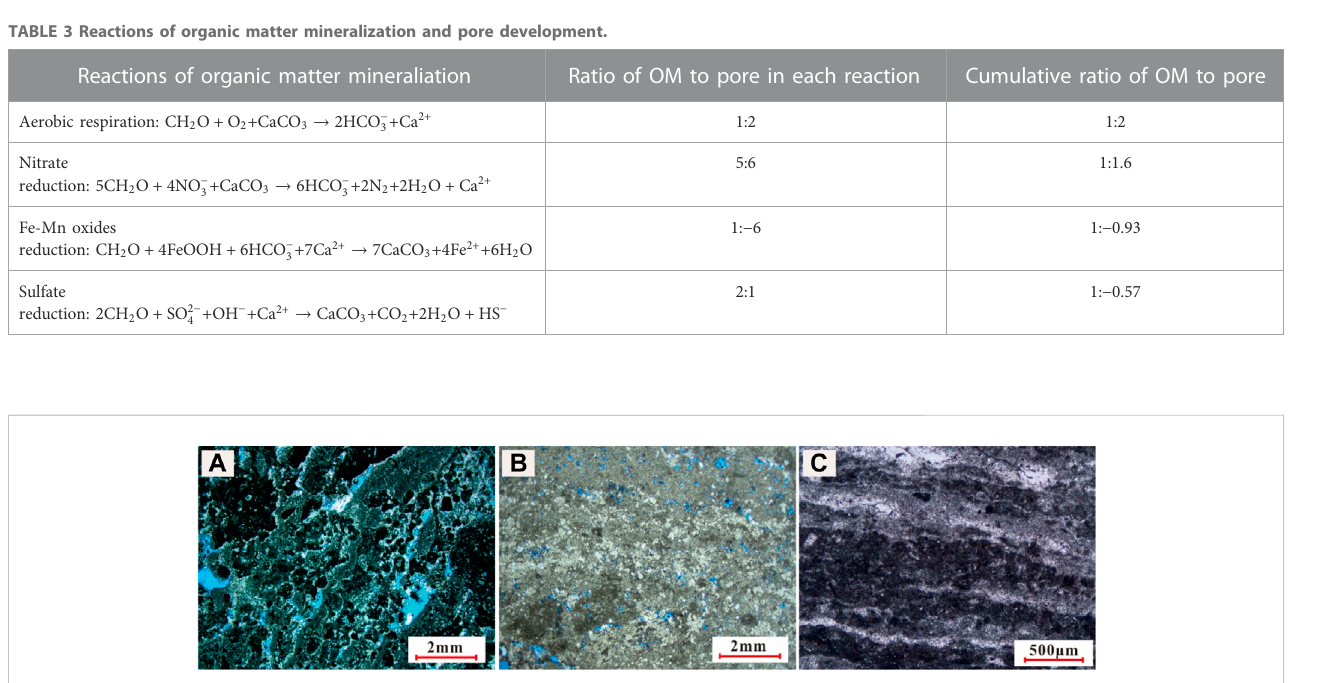
FIGURE 7 Microphotos showing three microbialites with different porosity. The blue area represents pores. (A) Sample YaS-28 has the highest porosity value of 9.11%; (B) Sample YaS-1 has moderate porosity value of 4.91%; (C) Sample YS-12 has lowest porosity value of